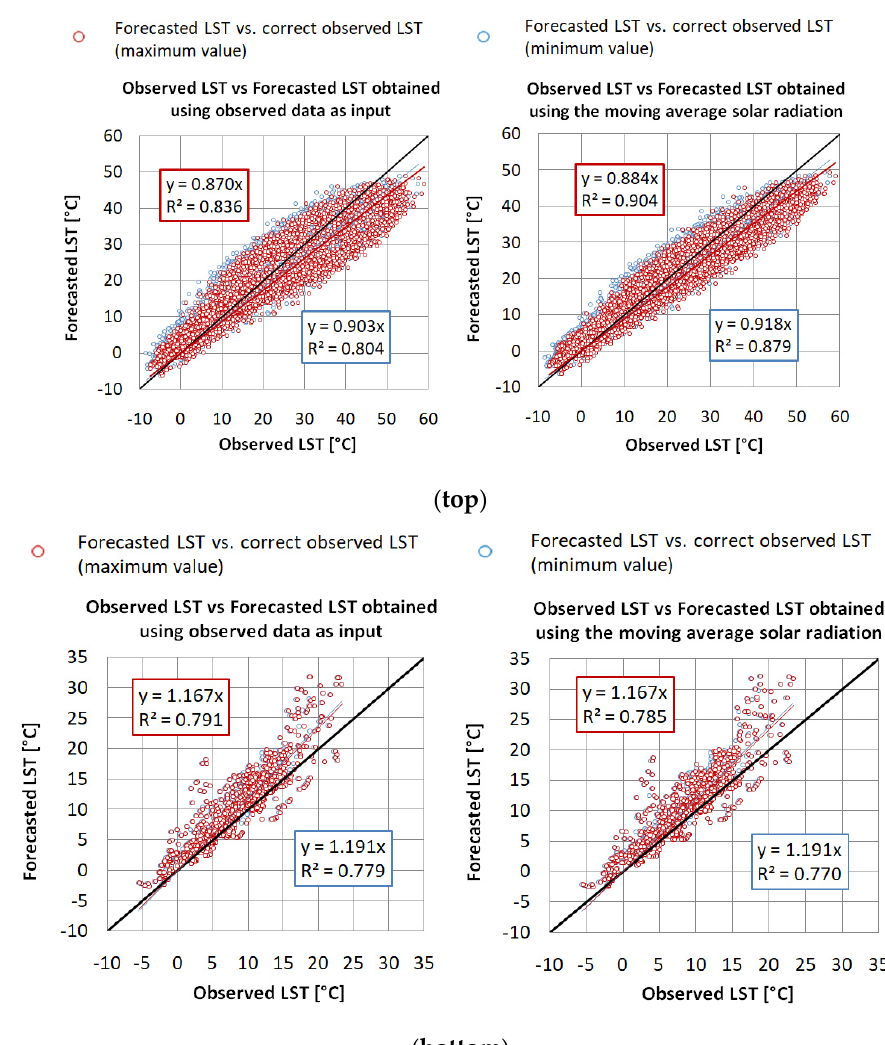
Figure 4. Scatterplot between observed vs. forecasted LST over the “Ponte Olona” station point during clear sky days ( top ). Scatterplot between observed vs. forecasted LST over the “Ponte Olona” station point during cloudy sky days ( bottom ). Table 5. Statistical indexes during clear sky days between observed and simulated LST values by the MEC algorithm using the hourly solar radiation and the 3 h-moving average as input.